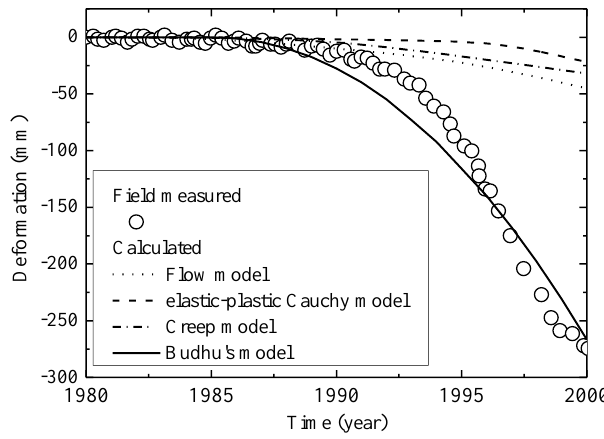
Figure 3. Comparison of the deformation of Aquifer IV at Laodong